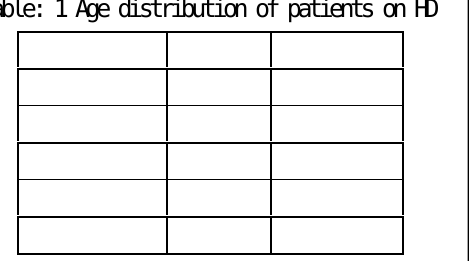
Nine HD sessions were carried out in the fist month